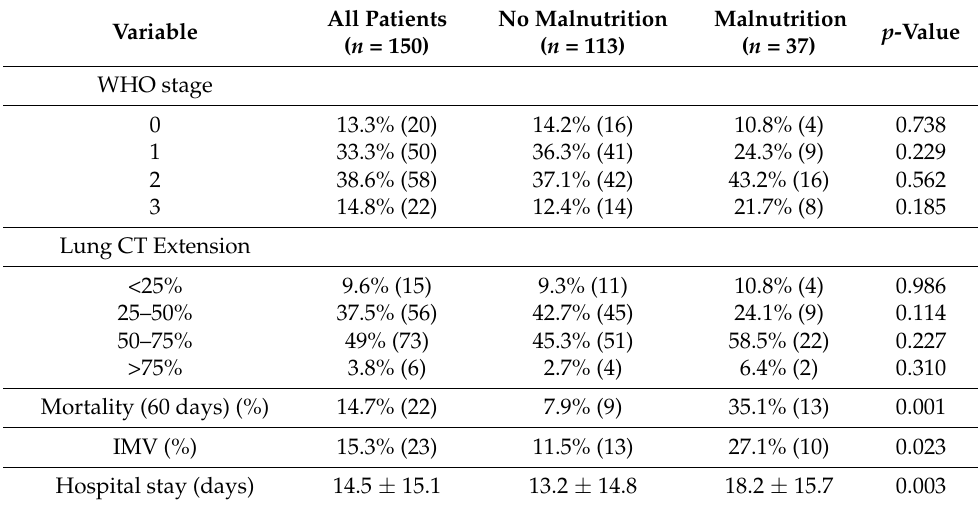
Table 3. Clinical severity of COVID 19 pneumonia (WHO stage), lung CT scan involvement, and outcome variables in the study patients. IMV: invasive mechanical